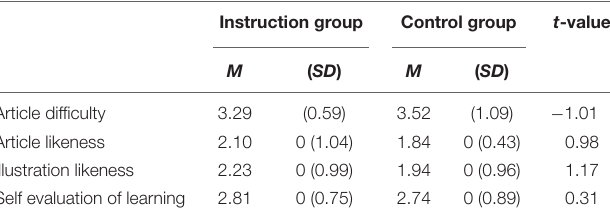
TABLE 3 | Means and standard deviations for eye-movement measures for instruction ( N = 31) and control ( N = 31) groups.